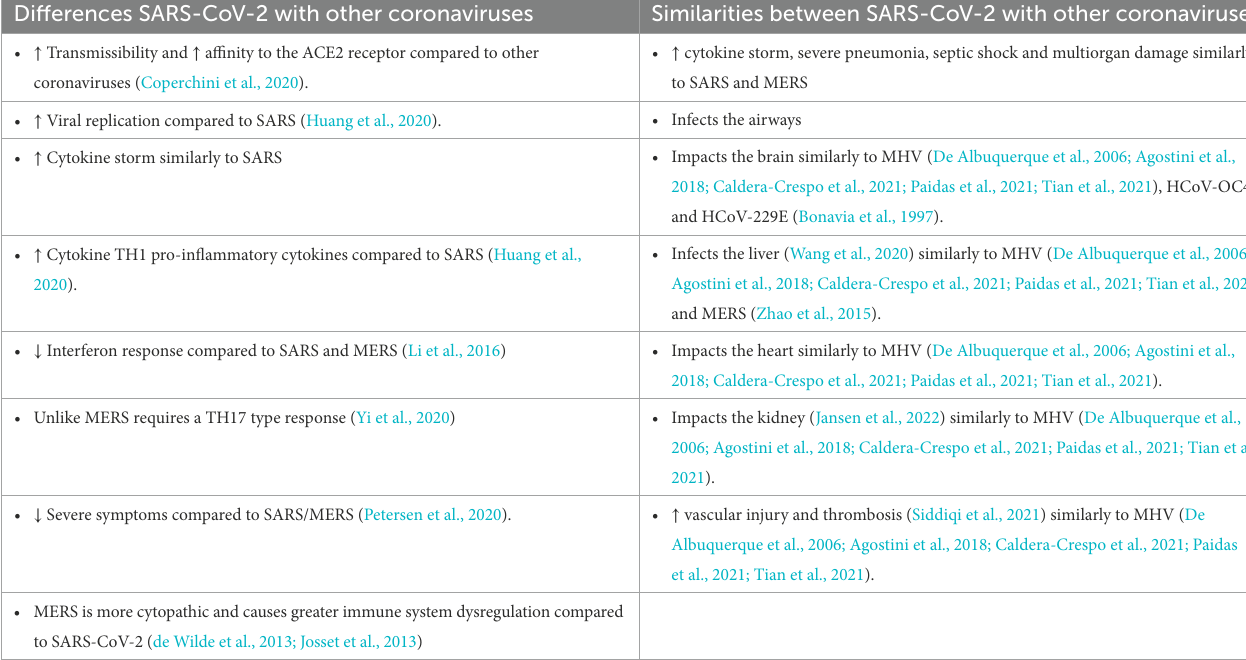
TABLE 3 Comparison of coronaviruses with regards to impact on end organ disease. Differences SARS-CoV-2 with other coronaviruses Similarities between SARS-CoV-2 with other coronaviruses